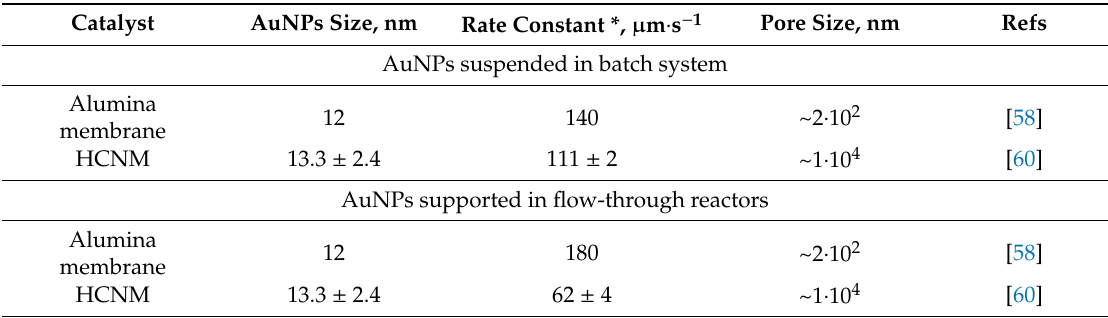
Table 6. Comparison of the first-order rate constants of 4-NP reduction catalyzed by suspended and HCNM-supported AuNPs.